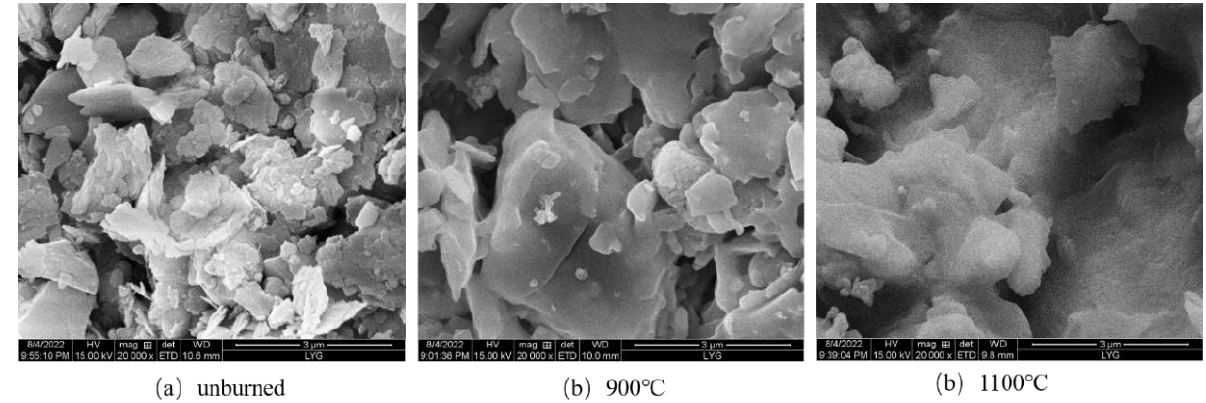
Figure 11. SEM spectrum of sintered bricks at different temperatures (3 µm).